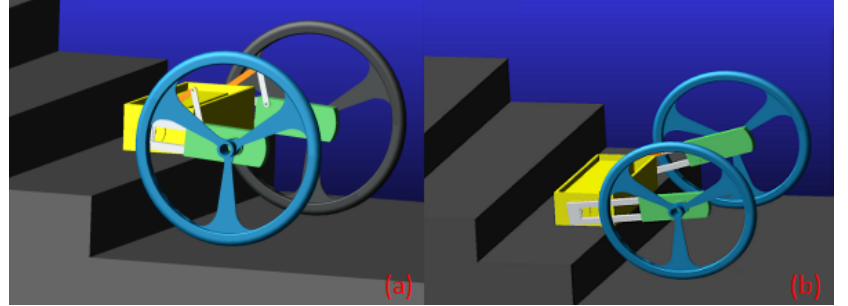
Figure 10. Gait simulation process diagram of “lifting and putting” during stair climbing: ( a ) the cantilevers drive the frame lifting due to the main drive motors’ blockage; ( b ) the frame is lifted to a certain angle and gradually lowered as the eccentricity increases.